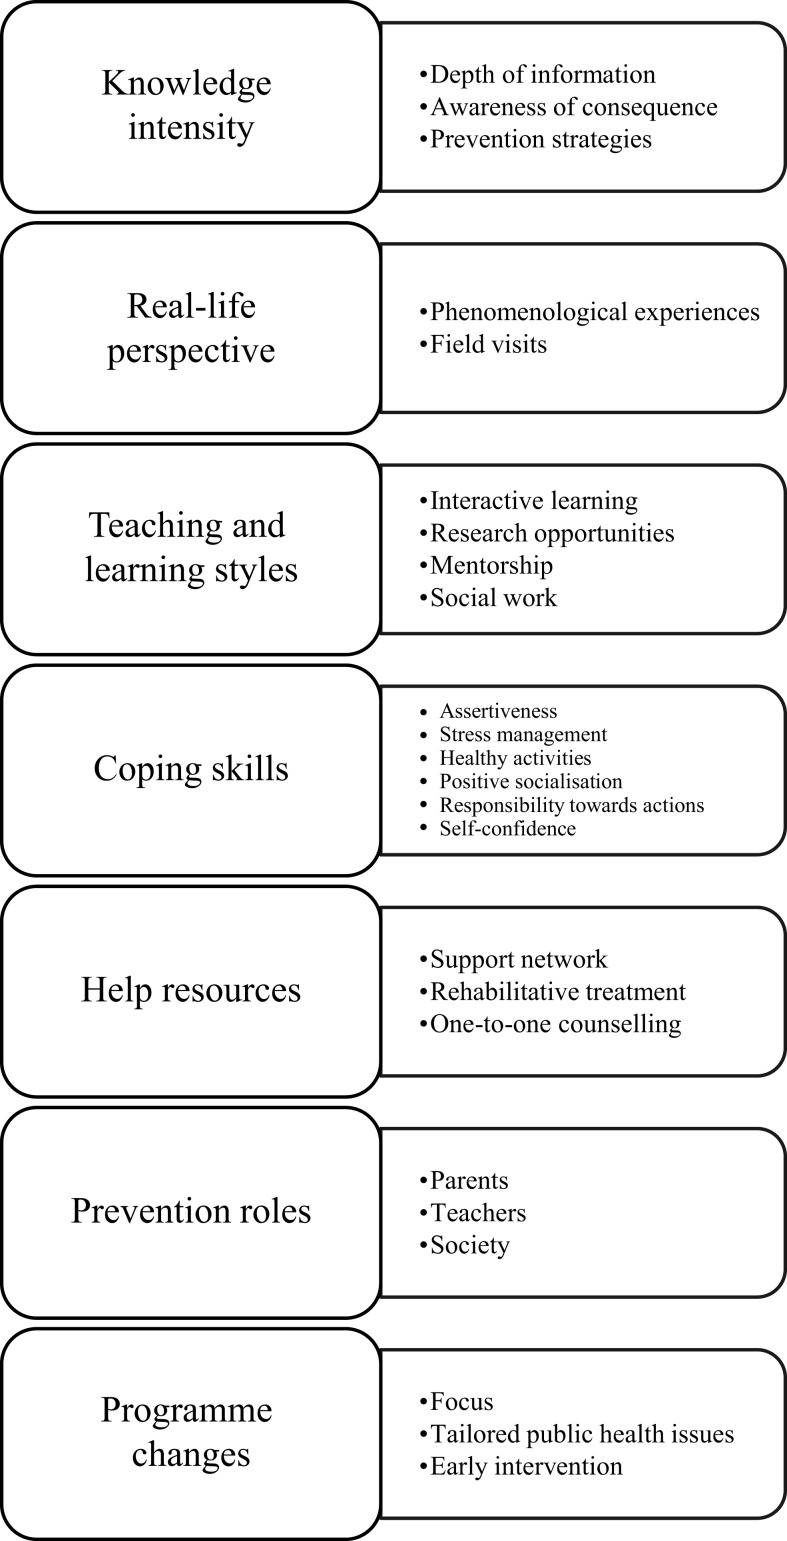
Thematic summary of suggestions for improvement in drug-prevention education.